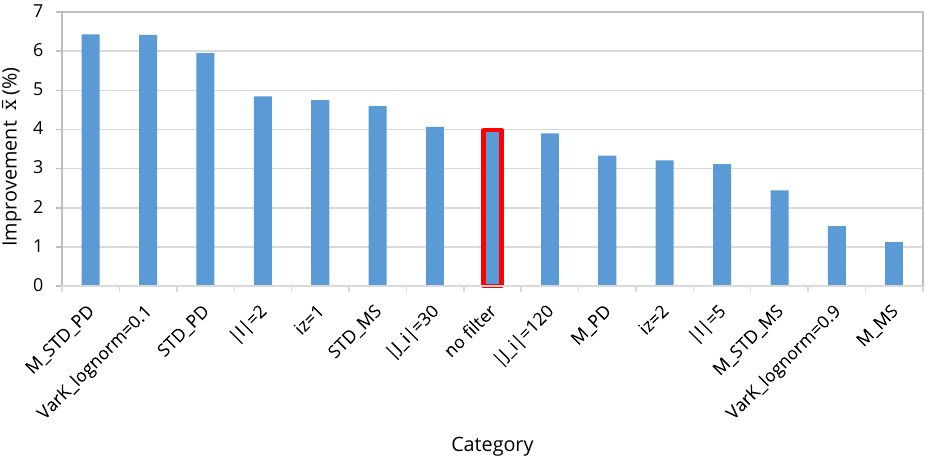
Figure 10. Performance of the proposed algorithm depending on the single